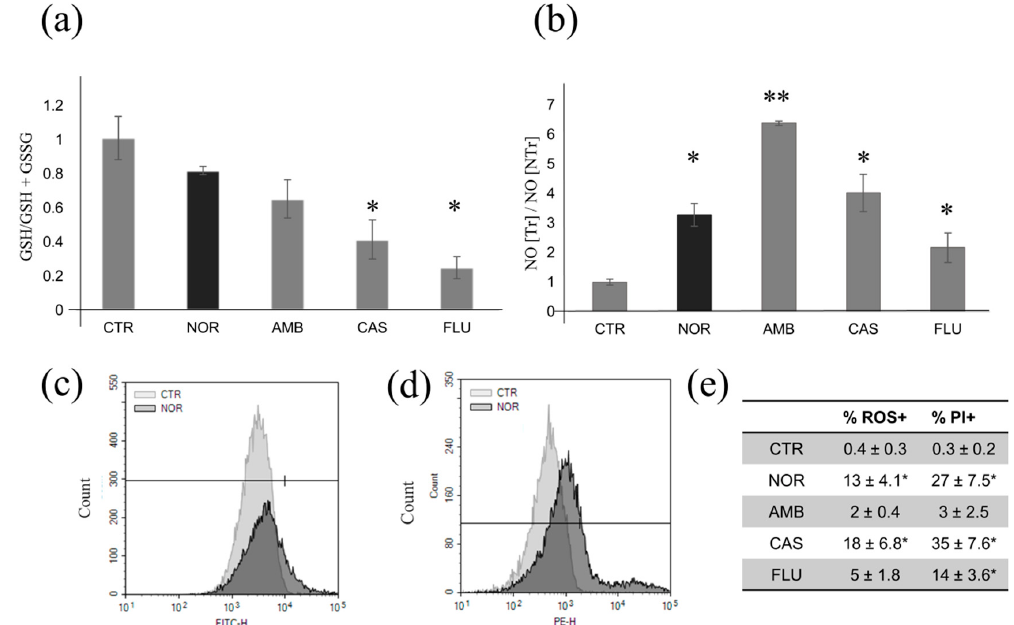
Figure 3. Oxidative stress in Candida albicans grown in the presence of NOR, AMB, CAS, or FLU: ( a ) effects of the drugs on glutathione oxidation state after 24 h of treatment; the results can be compared to those in the untreated control (CTR); ( b ) levels of nitric oxide (NO) of cells grown in the presence of the drugs for 24 h versus the CTR; ( c ) comparison of the distribution of cells reactive oxygen species